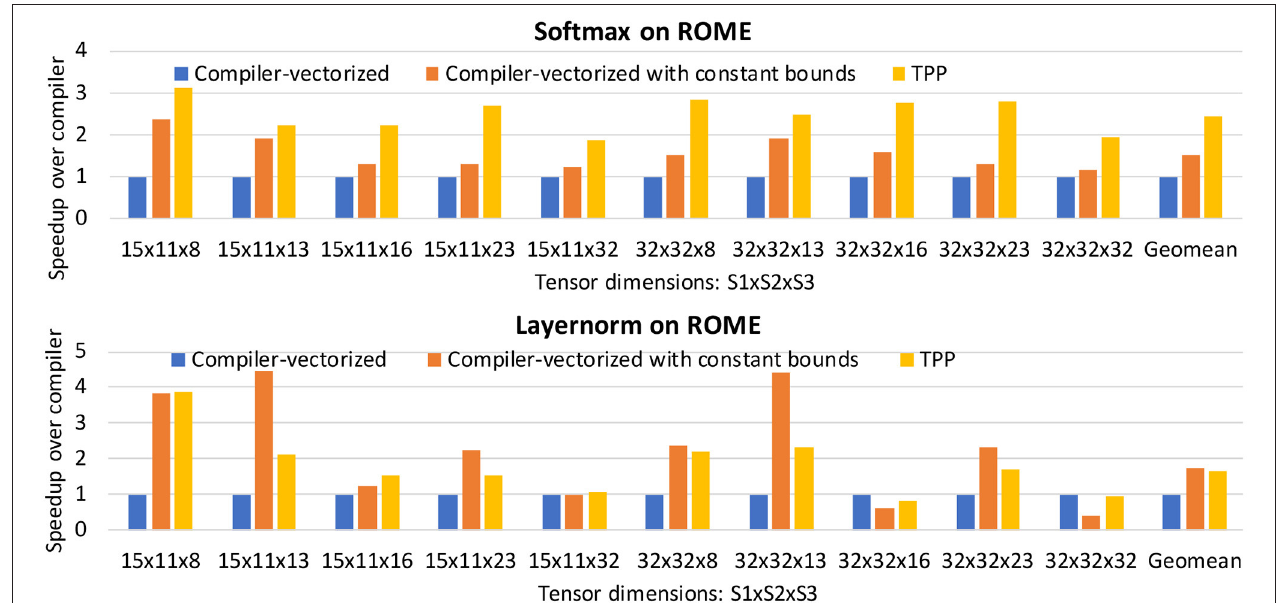
FIGURE 20 | TPP kernels on